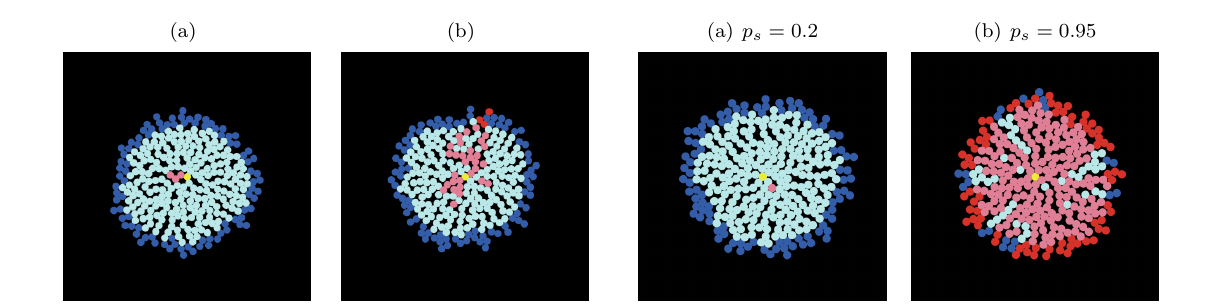
Figure 2: Two realizations of the simulation at low (a) and high (b) self-replication rates after 15 days. In (a) the CSCs are quickly surrounded by DCCs, becoming quiescent (pink). In (b) the high number of CSCs allows percolation to most of the colony perimeter. The seed is colored in